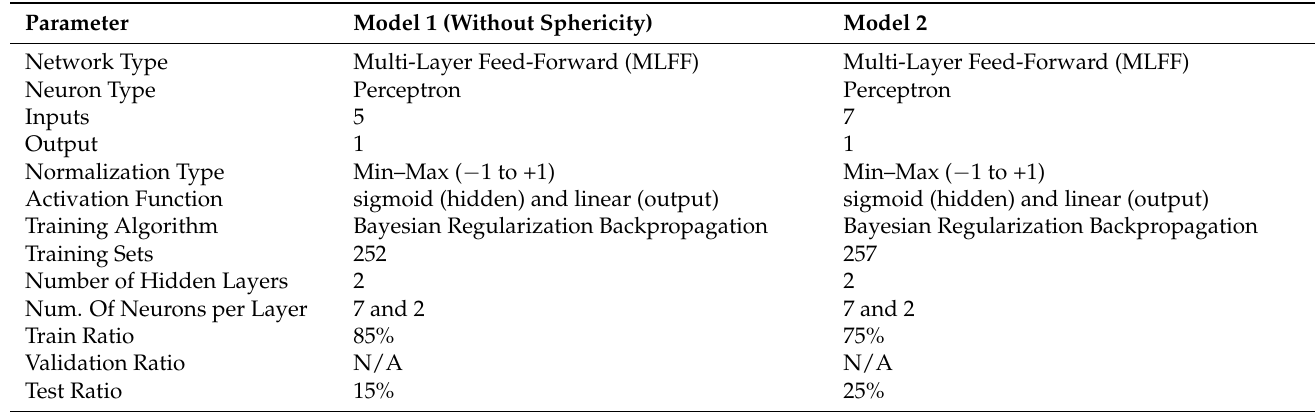
Table 2. Complete set of Artificial neural networks (ANN)